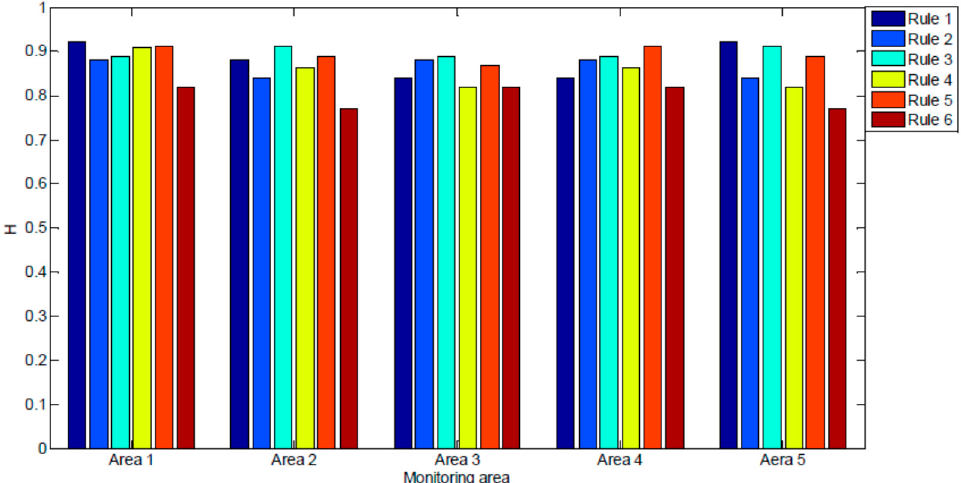
Figure 13. Prediction results for Ming Dynasty Great Wall dataset.